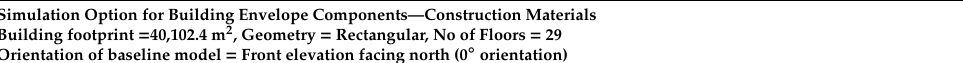
Constructive characteristics and design options of the base model of a 29-storey residential